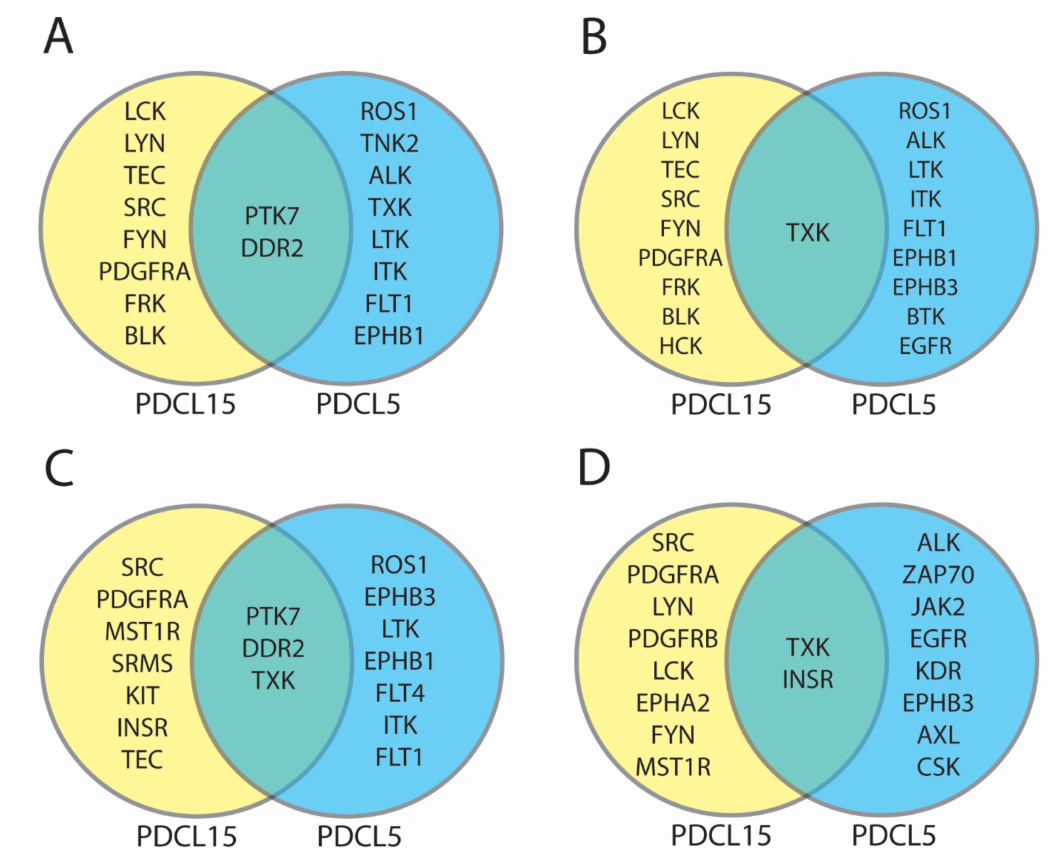
Figure A4. Comparison of protein tyrosine kinases identified in patient-derived cell lines. For each comparison yellow circles represent di ff erentially active protein tyrosine kinases in PDCL15, blue circles represent di ff erentially active protein tyrosine kinases in PDCL5, and green overlapping area represents di ff erentially active protein tyrosine kinases in PDCL15 and PDCL5. ( A ) Comparison of top 10 di ff erentially active protein tyrosine kinases according to UKA and KRSA average percentile rankings. ( B ) Comparison of top 10 di ff erentially active protein tyrosine kinases according to UKA and KRSA weighted average percentile rankings. ( C ) Comparison of top 10 di ff erentially active protein tyrosine kinases according to all pipelines (KRSA, UKA, PTM-SEA, and KEA3) average percentile rankings. ( D ) Comparison of top 10 di ff erentially active protein tyrosine kinases according to all pipelines (KRSA, UKA, PTM-SEA, and KEA3) weighted average percentile